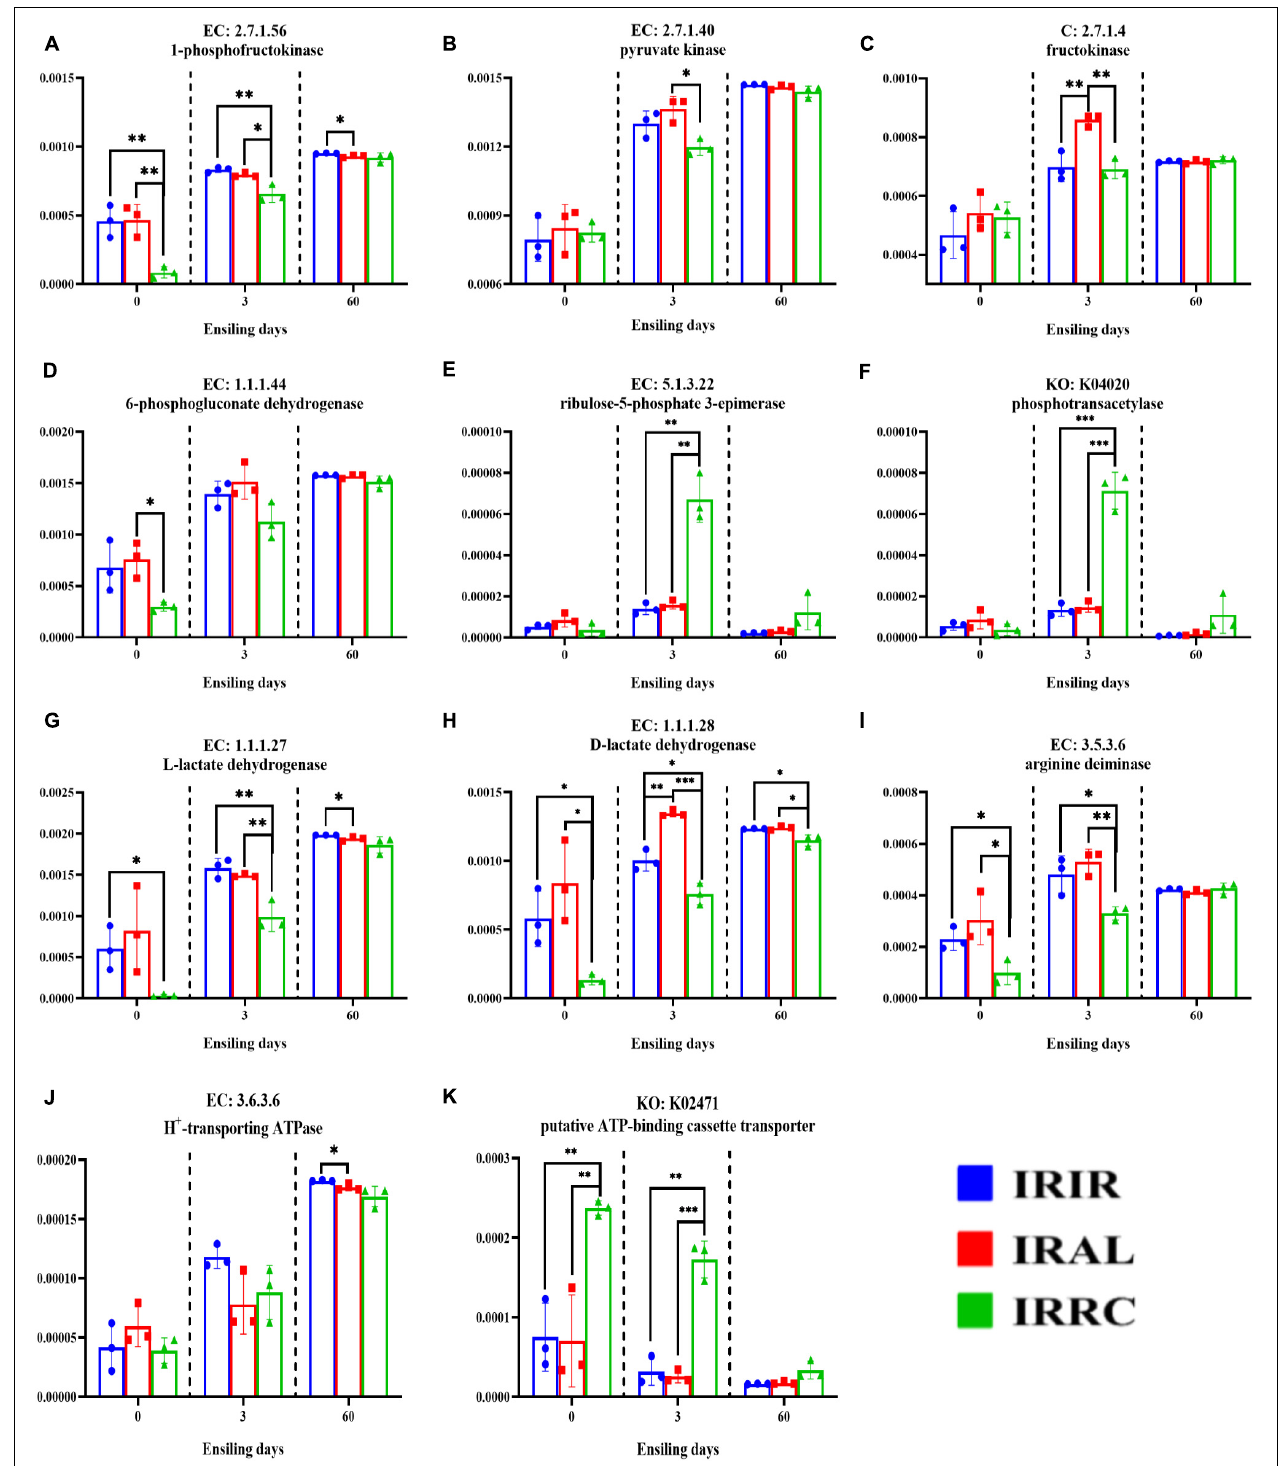
FIGURE 6 | Changes of relative abundances of key enzymes (A–K) involved in some metabolic pathways in fresh materials and Italian ryegrass silages. EC, reference metabolic pathway highlighting numbers; KO, KEGG Orthology; KEGG, Kyoto Encyclopedia of Genes and Genomes; IRFM, fresh material of Italian ryegrass; ALFM, fresh material of alfalfa; RCFM, fresh material of red clover; IRIR, sterile Italian ryegrass inoculated by epiphytic bacteria from Italian ryegrass; IRAL, sterile Italian ryegrass inoculated by epiphytic bacteria from alfalfa; IRRC, sterile Italian ryegrass inoculated by epiphytic bacteria from red clover; 3, 3 days of ensiling; 60, 60 days of ensiling. ∗ , 0.01 < p < 0.05; ∗∗ , 0.001 < p < 0.01; ∗∗∗ , p < 0.001.